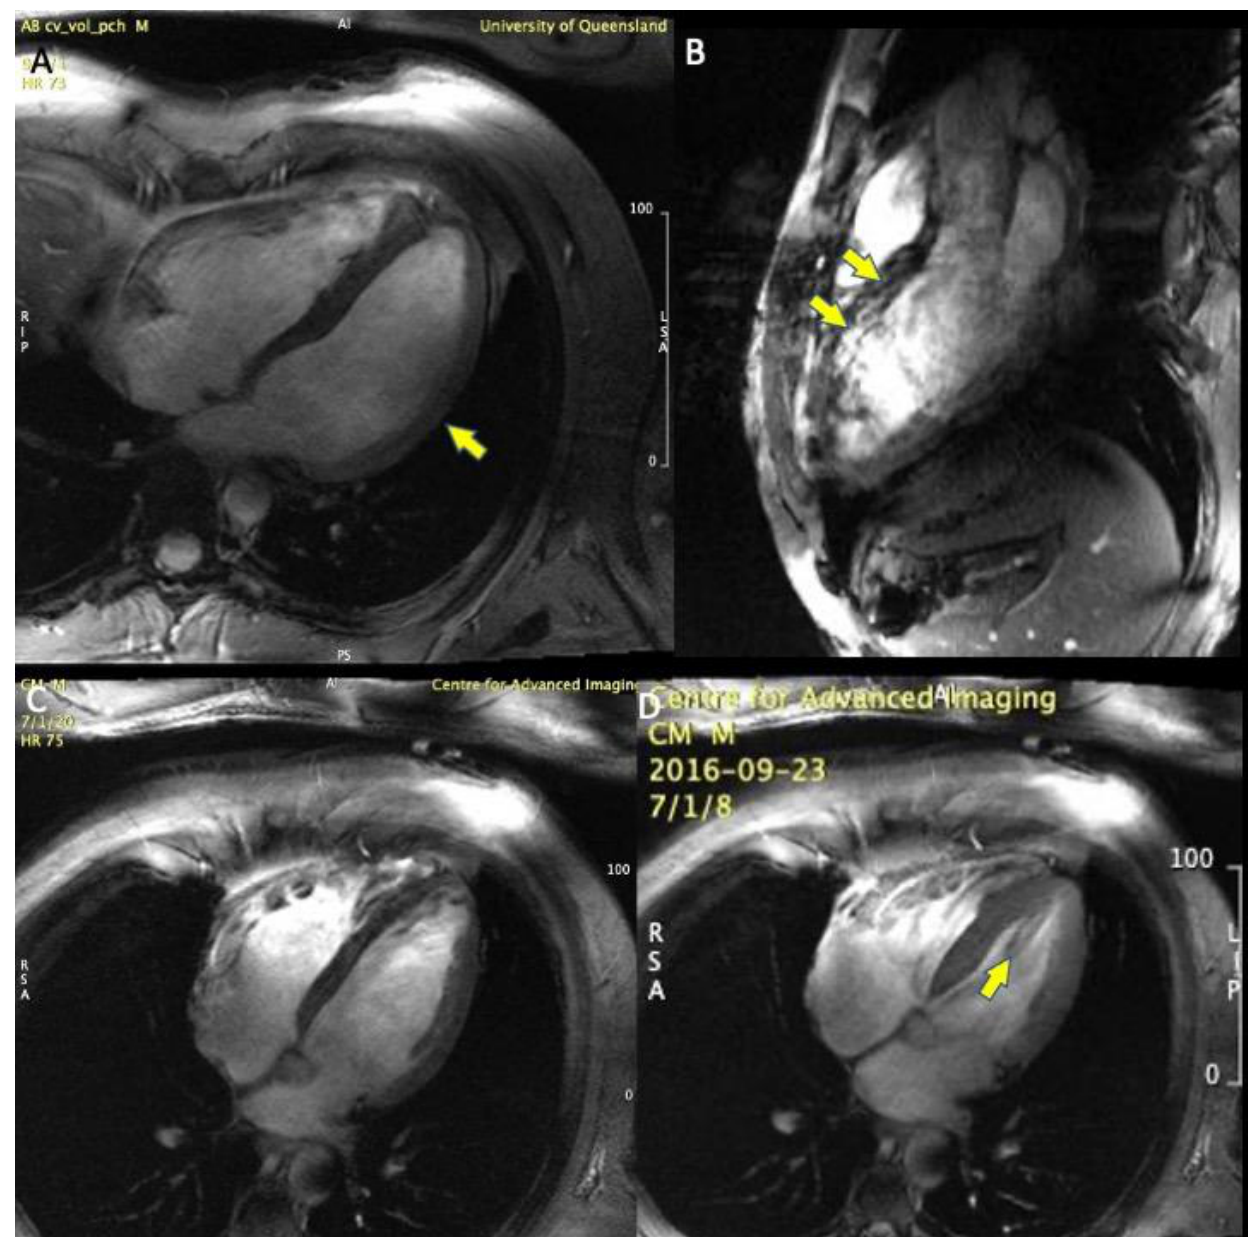
Figure 3. Image Quality of 7 T MRI with Vectorcardiogram gating. ( A ). 4 chamber view in diastole, showing good image quality, with mild signal dropout at the lateral left ventricular myocardial wall, yellow arrow (image quality score = 1). ( B ). 3-chamber view showing substantial artefacts from susceptibility and motion in the anteriorly placed structures of the right ventricular outflow tract and the anteroseptal myocardium yellow arrows (image quality score = 2). ( C , D ). 4-chamber diastolic and systolic frames, note the tricuspid valve leaflets are clearly seen in the closed position, and the mild flow artefacts in the left ventricular cavity during ejection, yellow arrow (image quality score = 1).